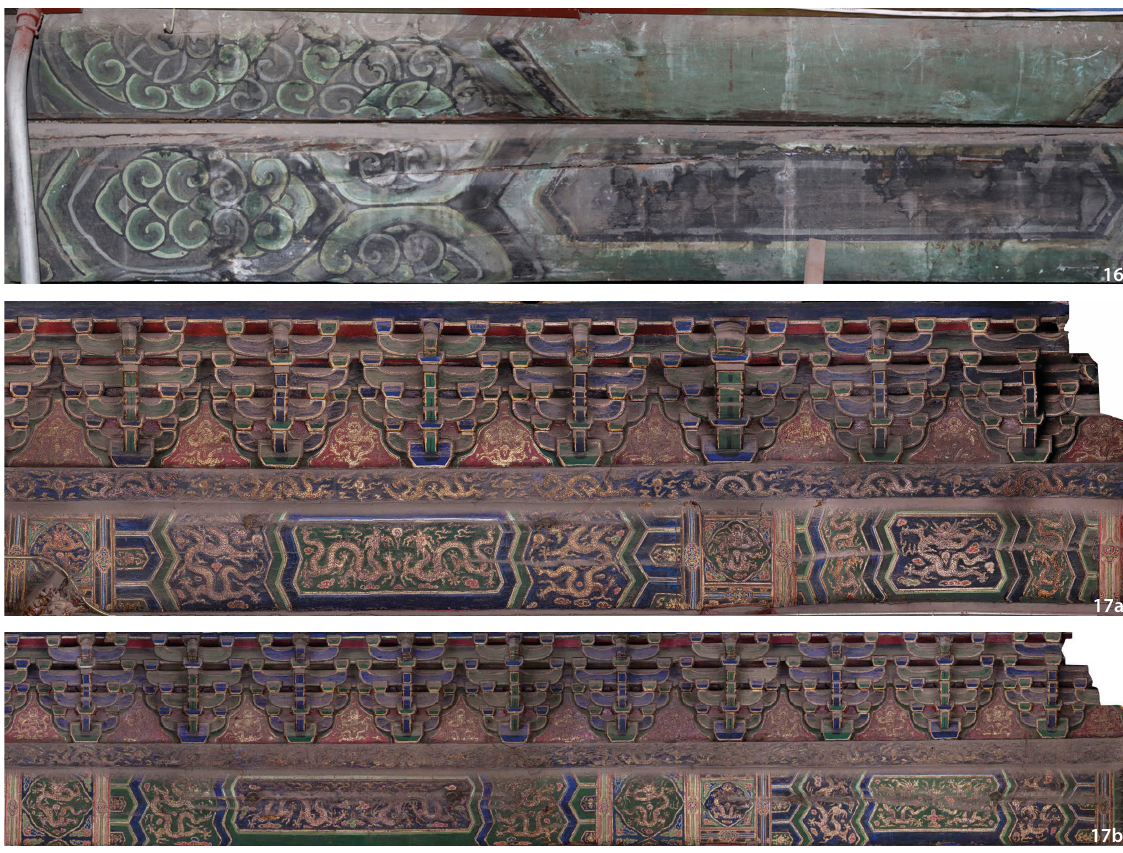
Figure 16 Decorative polychrome painting in the western surrounding building of the Hall of Mental Cultivation Complex (Source: Hong Yang). Figure 17a Decorative polychrome painting in the north central bay and the north adjacent bay of the west gable side of the three bays in the centre of the main hall (Source: Hong Yang). Figure 17b Decorative polychrome painting of the interior eave of the central bay of the maim hall (Source: Hong